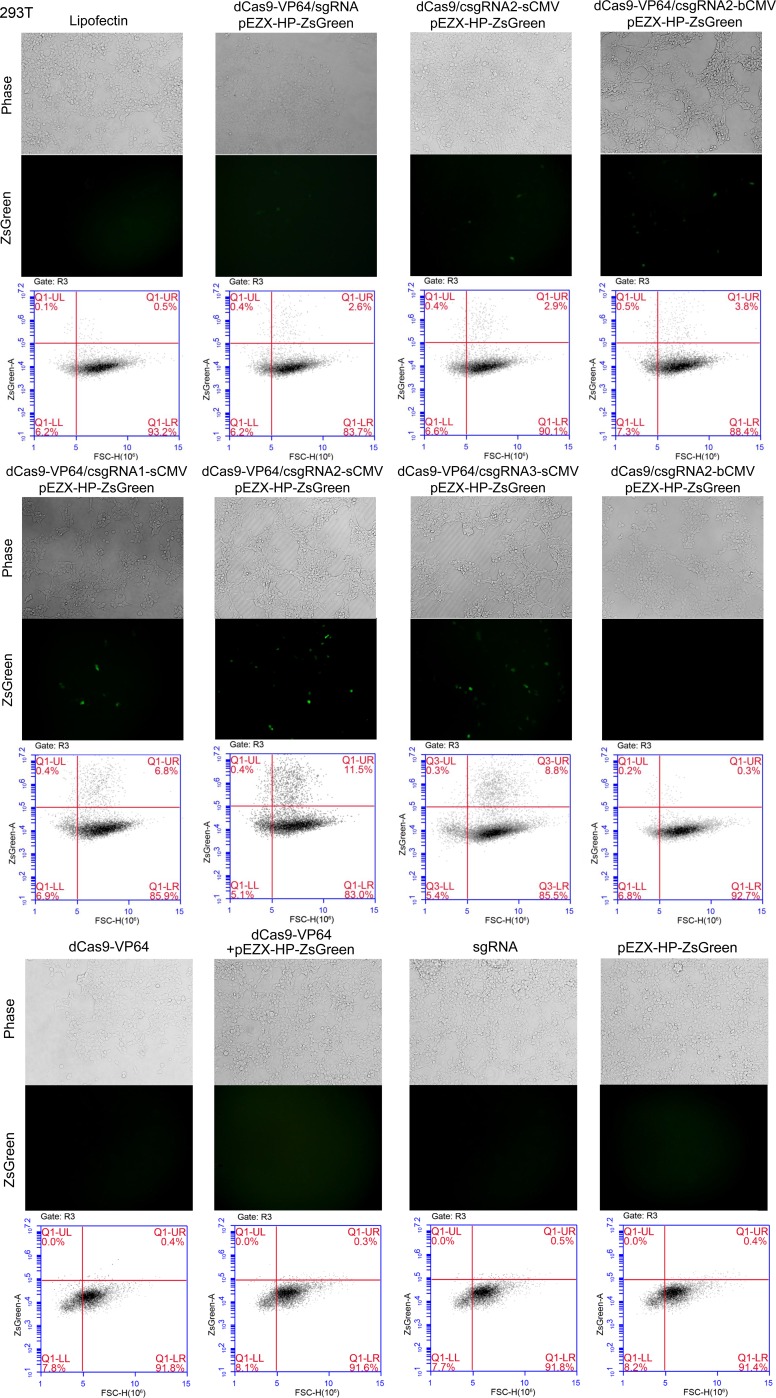
Activation of an exogenous reporter gene ZsGreen under the control of a HNF4α promoter by the CRISPR-assisted trans enhancer in 293 T cells.Cells were transfected by various vectors. Cells were photographed with a fluorescent microscope and their florescence was analyzed by flow cytometry. The reporter gene activation efficiency was indicated by the percentage of cells with green fluorescence over the threshold (cells in Q1-UR quadrant).